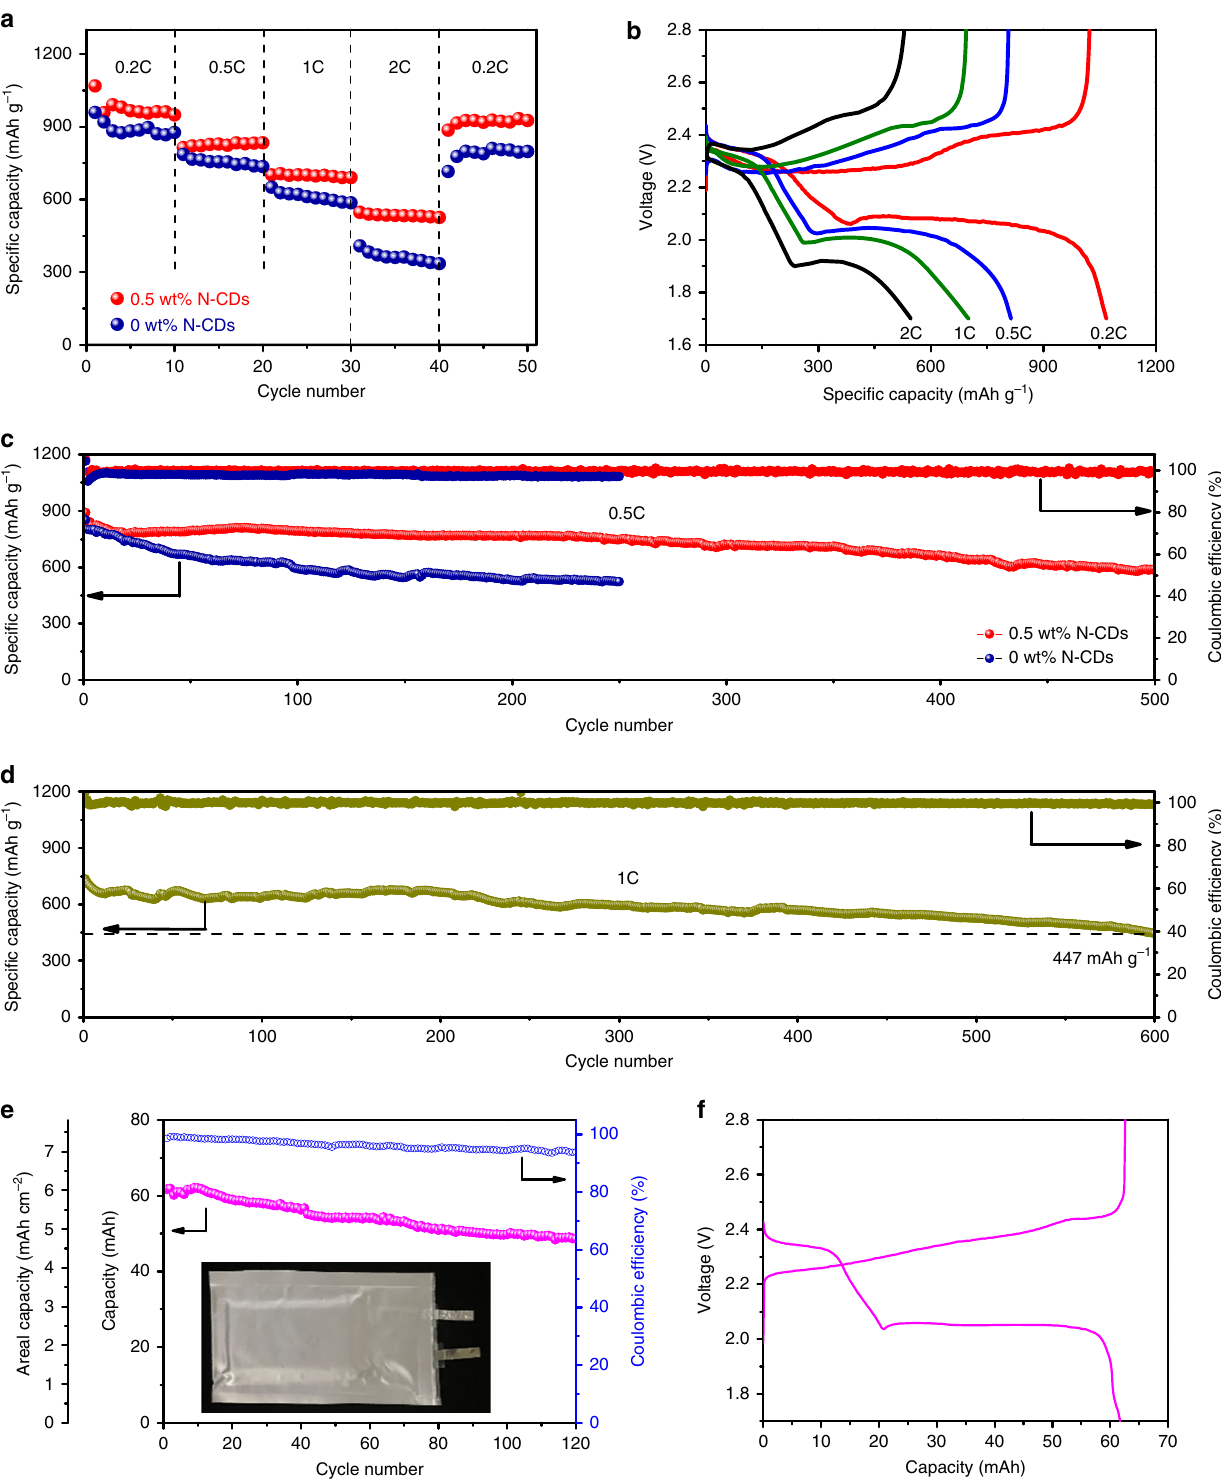
1.82.02.22.42.62.8 Fig. 4 The electrochemical performance of a Li – S cell with 0.5wt% N-CDs. a Rate performance of the cell with 0 and 0.5wt% N-CDs electrolyte. b Voltage pro fi les of the cell with 0.5wt% N-CDs electrolyte at different current densities. c , d Long-term cycling performance of Li – S cells with 0.5wt% N-CDs electrolyte at 0.5 and 1.0C. e , f Galvanostatic cycling performance and voltage pro fi le for the Li – S pouch cell with 0.5wt% N-CDs electrolyte at Supplementary Fig. 9, the cell with 0.5 wt% N-CDs electrolyte exhibits higher rate performances than the cells with 0, 0.3, and 1.0 wt% N-CDs electrolyte, especially when the current density is high. The delivered discharge capacity of the cell with 0.5 wt% with sulfur loading of ~2 mg cm − 2 . As shown in Fig. 4a, b and